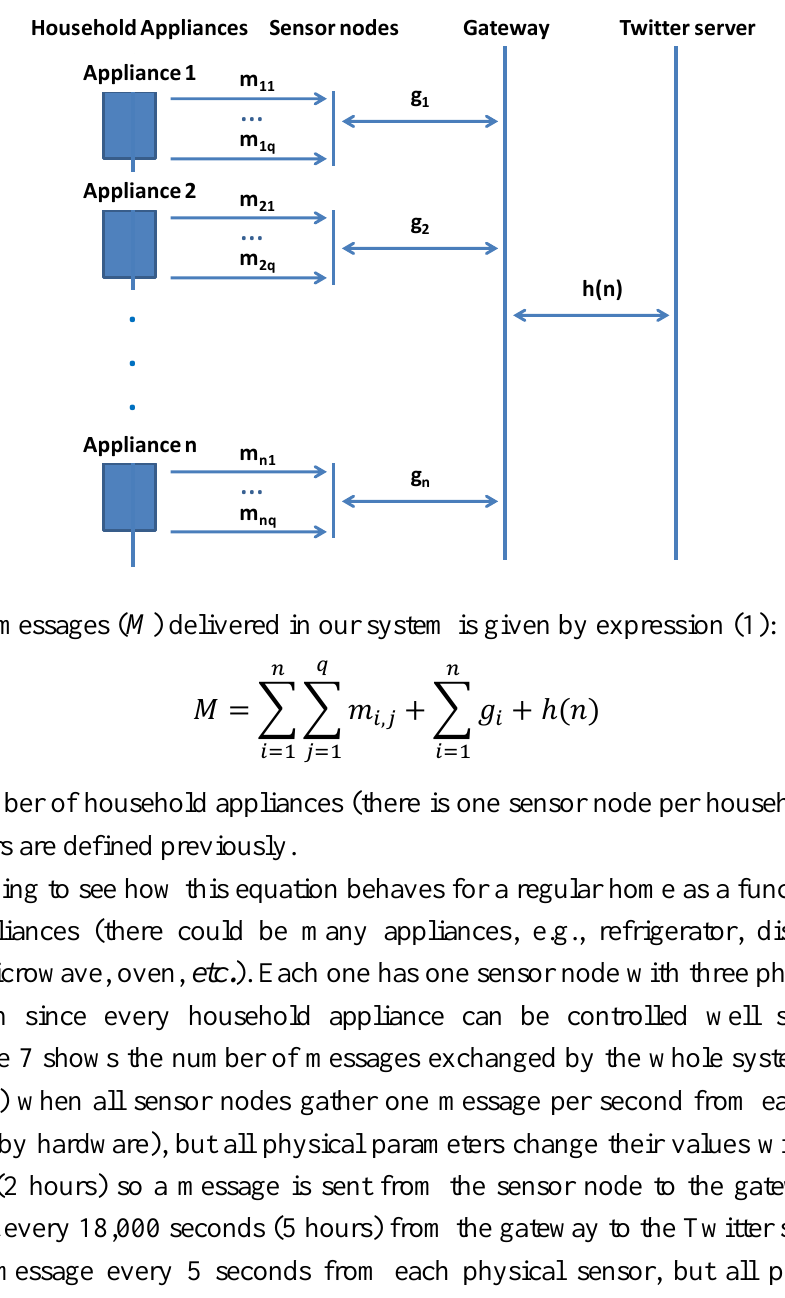
Figure 6. Analytical view of our